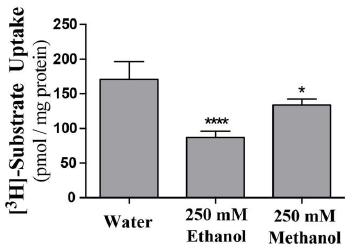
Figure 4. Alcohol attenuation of ScENT1-mediated uridine transport. Ethanol and methanol attenuation was determined by pre-incubating (–OH) PLs with 250 mM of the denoted alcohol or an equal volume of water for 15 min, then incubating with 100 mM of [ 3 H]-uridine for an additional 3.5 h followed by vacuum filtration onto membranes. Error bars represent the S.E.M. of N = 3 independent experiments. Negative control PLs and substrate specific activity are included in the pmol substrate/mg ScENT1 calculation for each sample. Statistical significance was determined using a one-way analysis of variance and Dunnett’s multiple comparison tests (* p < 0.05; **** p < 0.0001).